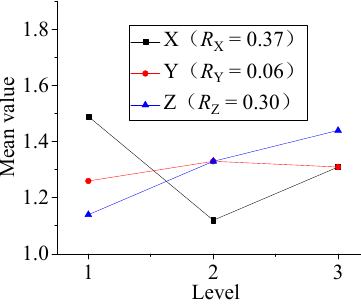
Figure 9. Parameter range analysis of film resistivity.